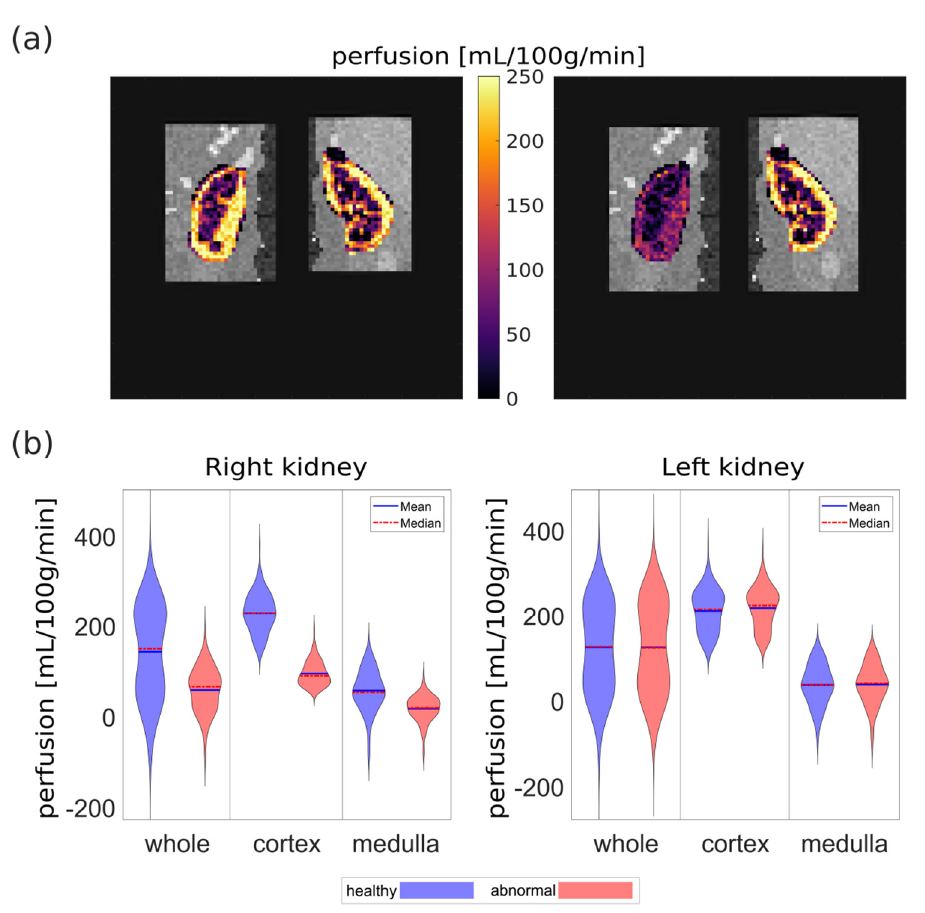
Figure 3. ( a ) M0 image cropped to rectangles used for separate left and right registration with overlaid perfusion map obtained for the healthy (left) and abnormal (right) PCASL data sets of model 92. ( b ) Distributions of perfusion values for both data sets.